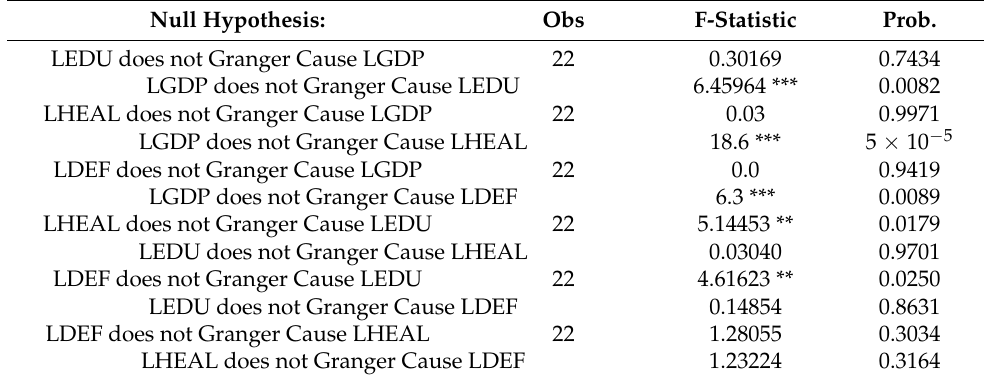
Table 8. Granger Pairwise causality